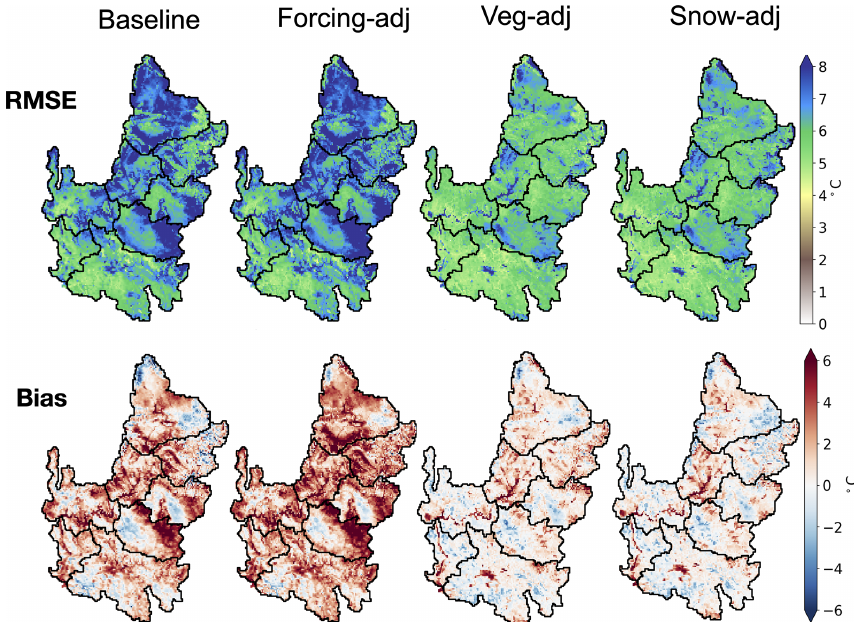
Figure 10. Same as Fig. 9 but for daytime